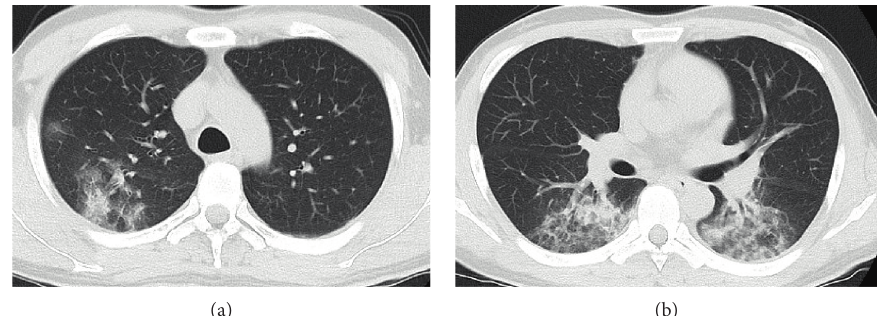
Figure 2: Preoperative chest computed tomography (CT) radiological findings. A chest axial CT in the lung window setting showed a consolidation and ground-glass opacity in the posterior segments of the right upper lobes (a) and the superior segments of the bilateral lower lobes (b), consistent with aspiration